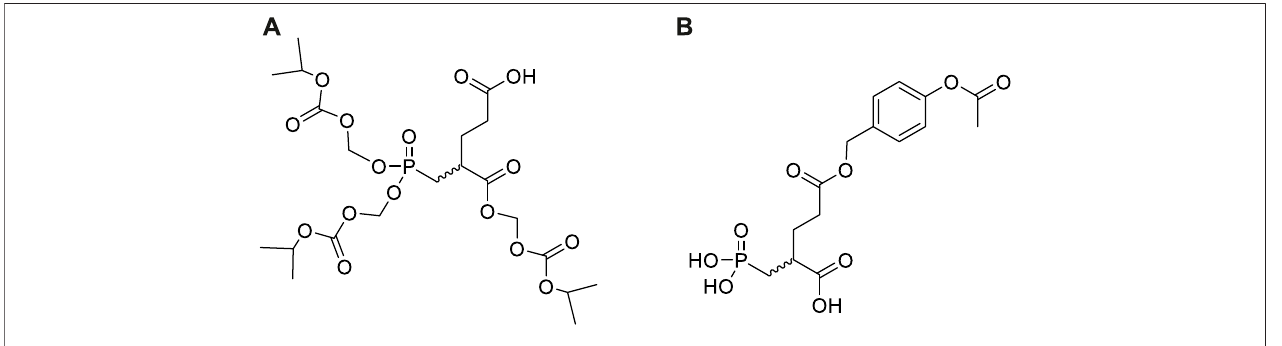
FIGURE 16 | Structures of tris-POC 2-PMPA (A) and γ -(4-acetoxybenzyl)-2-PMPA (B) .